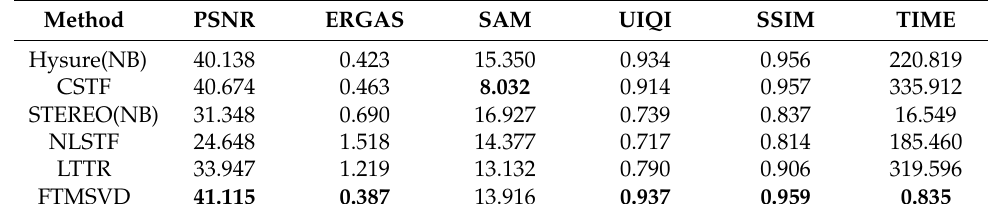
Table 4. Average quantitative results of the non − blind methods on the CAVE data set.